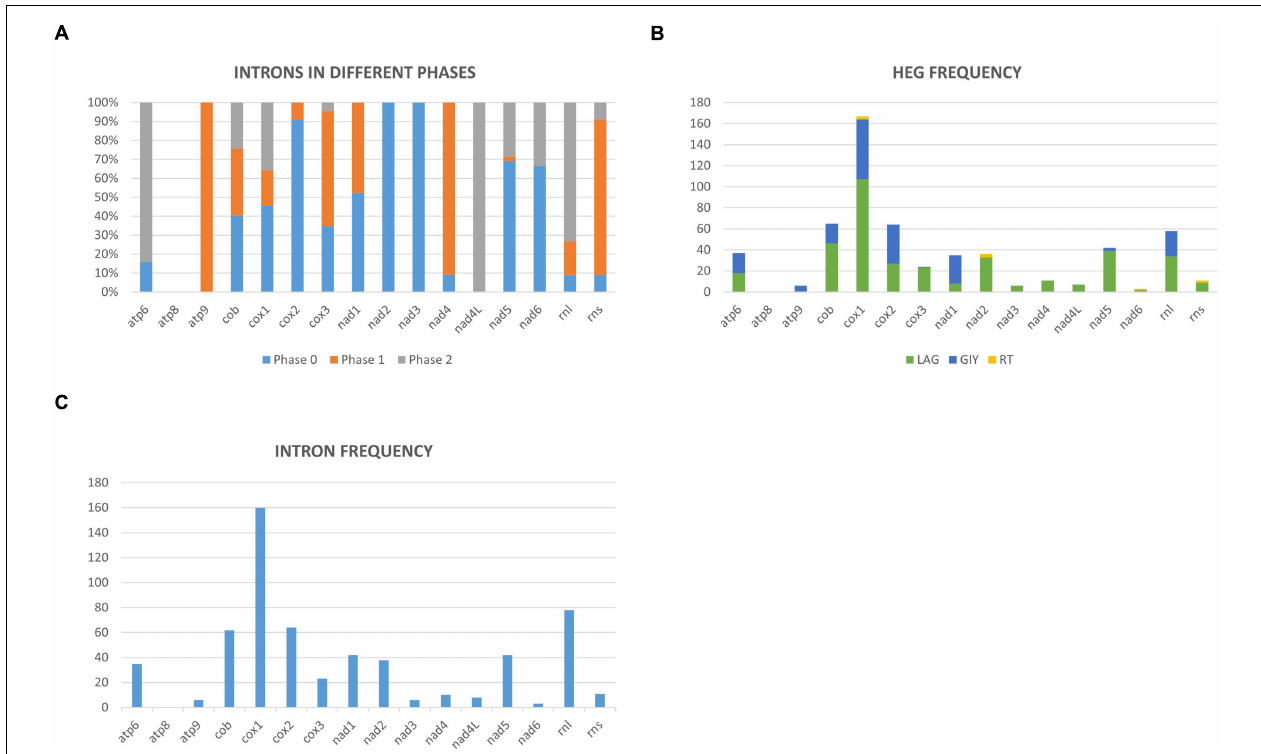
FIGURE 3 | (A) Mitochondrial introns of the Ophiostomatales categorized according to intron phasing on a gene by gene basis. (B) Representation of the relative frequencies of different types of introns encoded open reading frames based on gene by gene basis (LAG, LAGLIDADG type homing endonucleases/maturases; GIY, GIY-YIG type homing endonucleases; RT, reverse transcriptases). (C) Relative distribution and number of mitochondrial introns recorded on a gene-by-gene basis among the examined members of the Ophiostomatales.